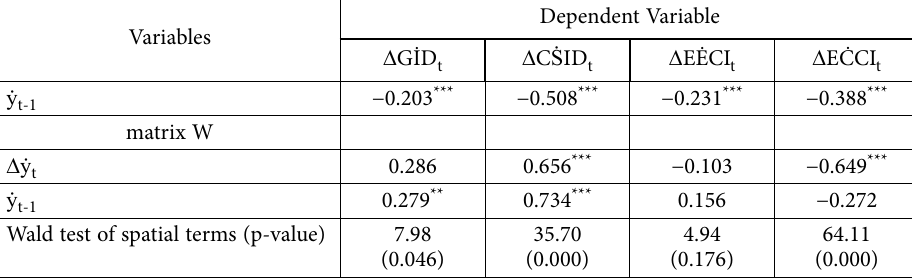
Table 3. Estimates of model parameters for detailed indicators